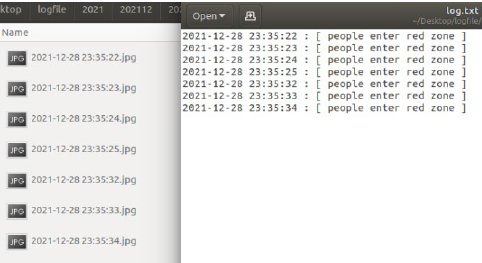
Figure 16. Contents of the logfile.